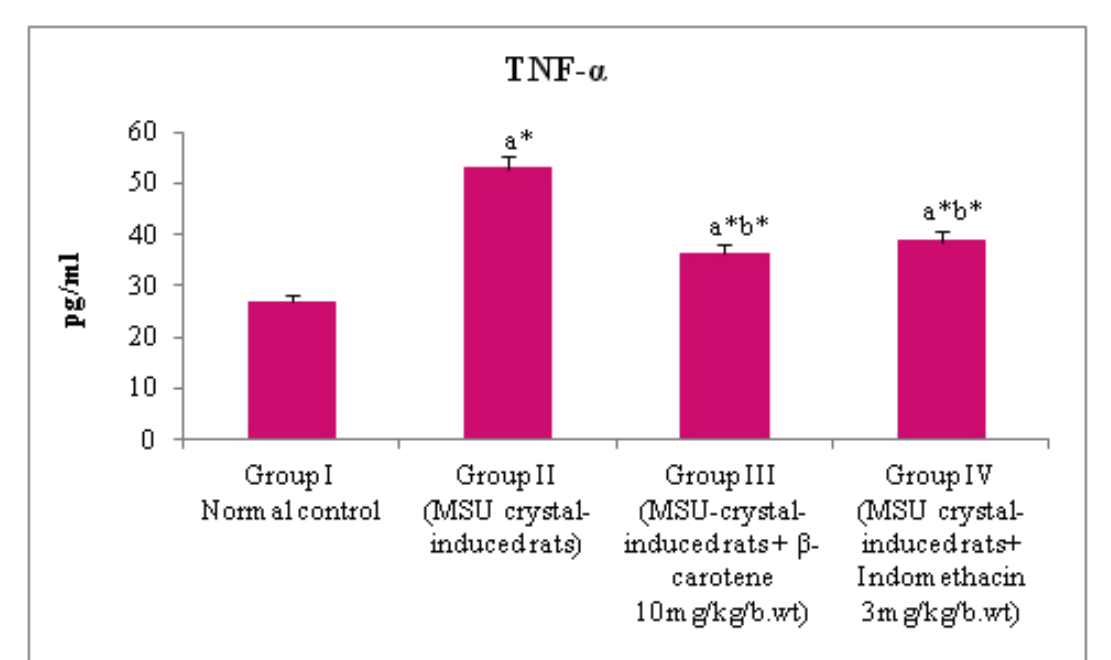
FIGURE 5 - Effect of β -carotene on serum TNF- α of MSU crystal-induced arthritis N=6 animals in each group. The values are expressed as mean ± S.D. Comparisons indicated by lower case letters were made as follows: a – group I vs. group II, III and IV; b – group II vs. group III and IV; c – group III vs. group IV. Statistical analysis was carried out by one way ANOVA followed by Student’s Newman – Kuel’s test. The symbols represent statistical significance at: * p < 0.05.